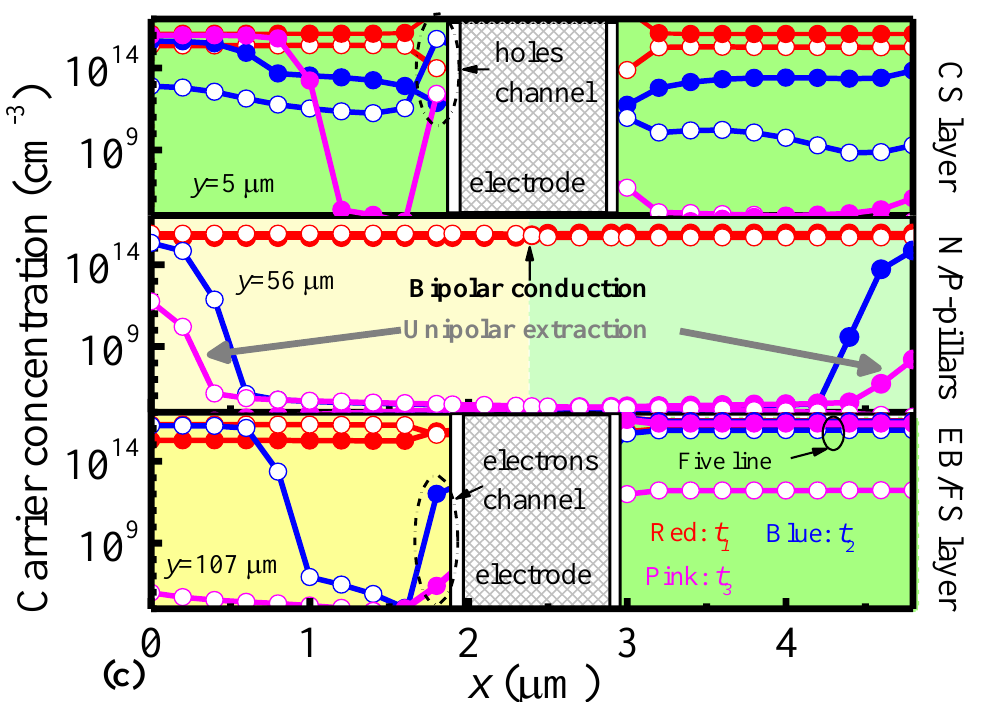
Figure 8. ( a ) Turn-off waveforms of SJ-RC-IGBT, SJ-IGBT, and CRC-IGBT. The inset shows the simulation circuit with R G = 10 Ω and Ls = 5 nH. ( b ) Electron current (I e ), hole current (I h ), and total current (I total ) at the collector of SJ-RC-IGBT, SJ-IGBT, and CRC-IGBT during turn-off. ( c ) Electron/hole concentrations in CS layer, N/P-pillars, and EB/FS layer of SJ-RC-IGBT. Hollow and solid represent hole and electron, respectively.